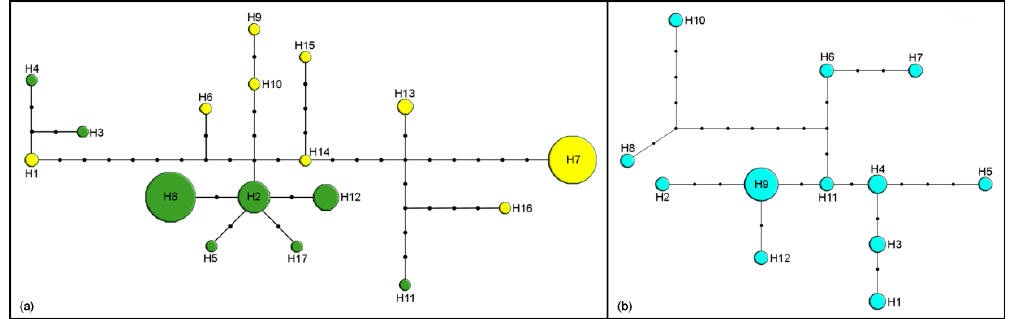
Figure 1. Haplotype networks based on cytochrome c oxidase subunit I ( COI ) sequences. Size of circles indicates the number of specimens with a haplotype; black dots represent one nucleotide substitution: ( a ) M. washingtonensis (yellow—west haplotypes, green—east haplotypes); ( b ) M. paulensis .